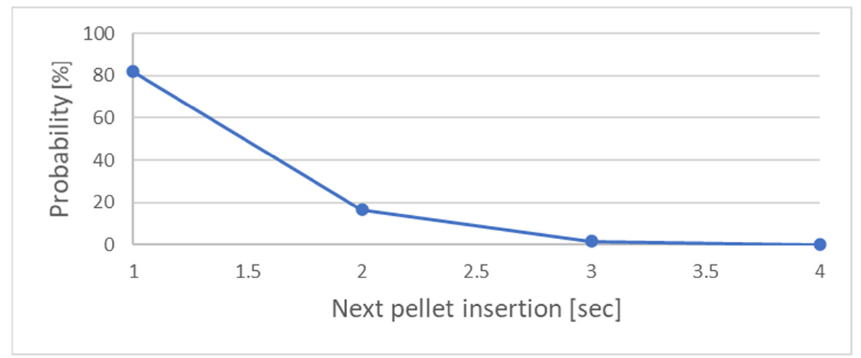
Figure 11. Probability of the pellet insertion depending on elapsed time since the last insertion.